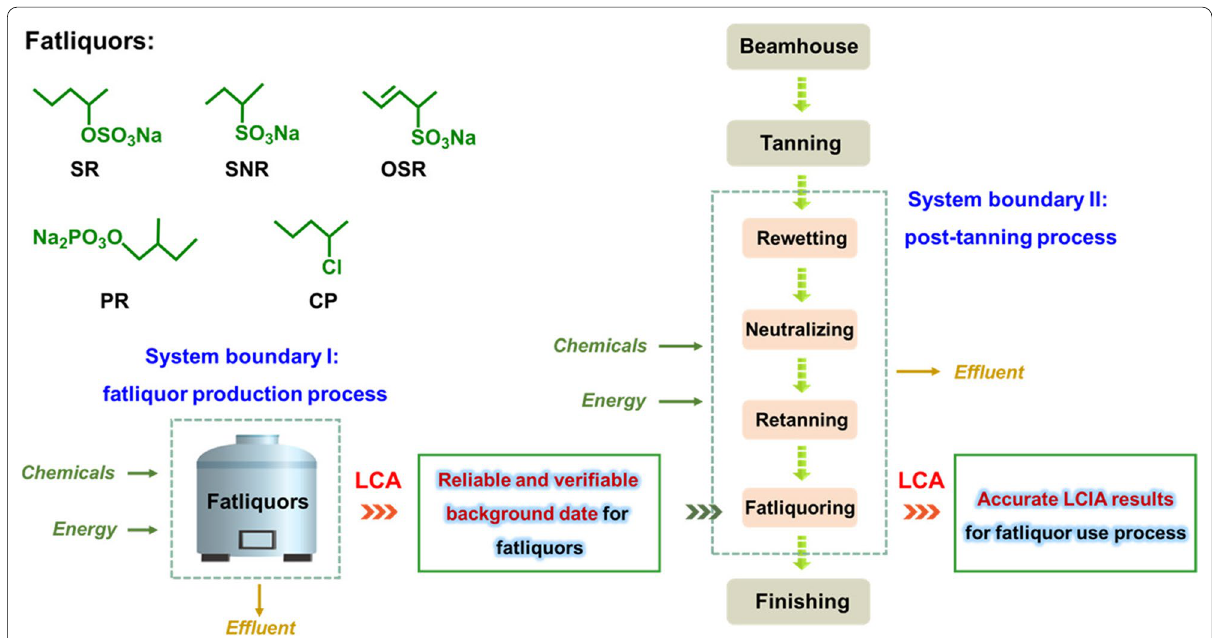
Fig. 1 System boundaries of fatliquor production and use